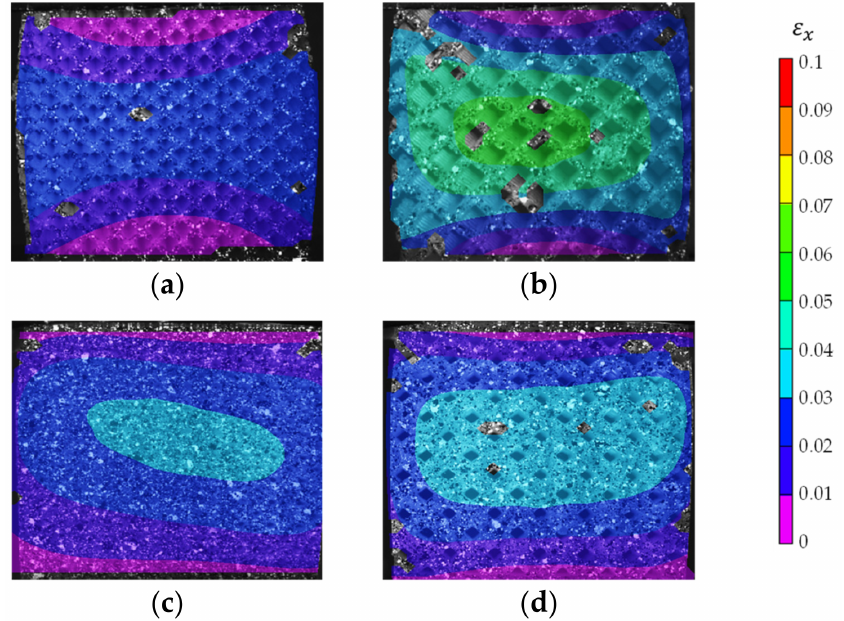
Figure 13. Digital Image Correlation (DIC) results of the boundary lattice designs depicting the engineering strain distribution in the horizontal direction at 10% compressive strain for ( a ) LDSS, ( b ) LDLS, ( c ) HDSS, and ( d ) HDLS boundary